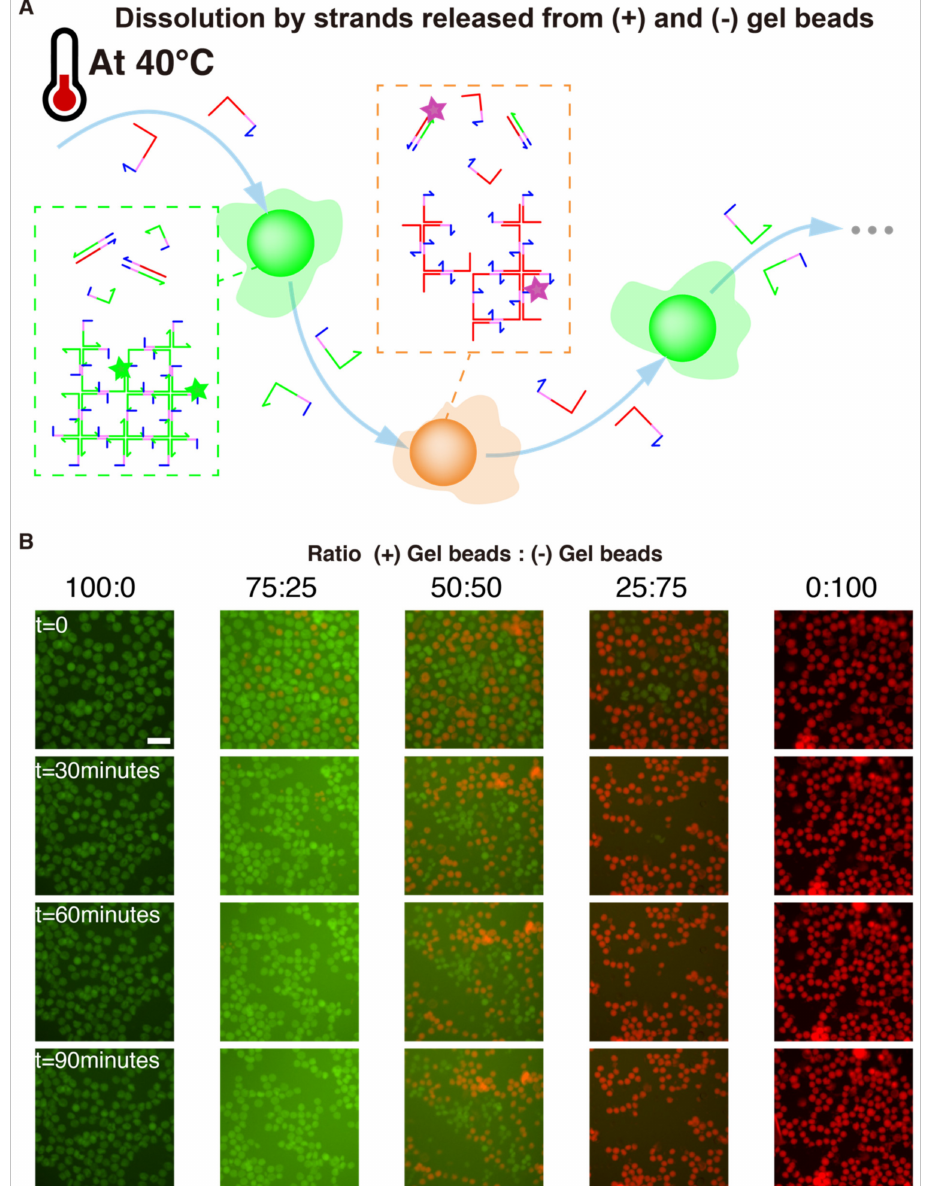
Figure 6. Winner-Takes-All competition between gel beads. ( A ) (+) and (-) gel beads are perfectly complementary, and should mutually “dissolve” each other to leave only fully paired duplexes. However, this process is slow at room temperature. We hypothesized that heating the solution would catalyze this thermodynamically downhill process. Once a strand is peeled from a X-motif, this exposes more single-stranded domains which can react with their complement in the other population of gels. ( B ) Fluorescence time-lapse of gel beads and (-) gel beads mixed in various ratios at 40 ◦ C. The scale bar is 150 µ